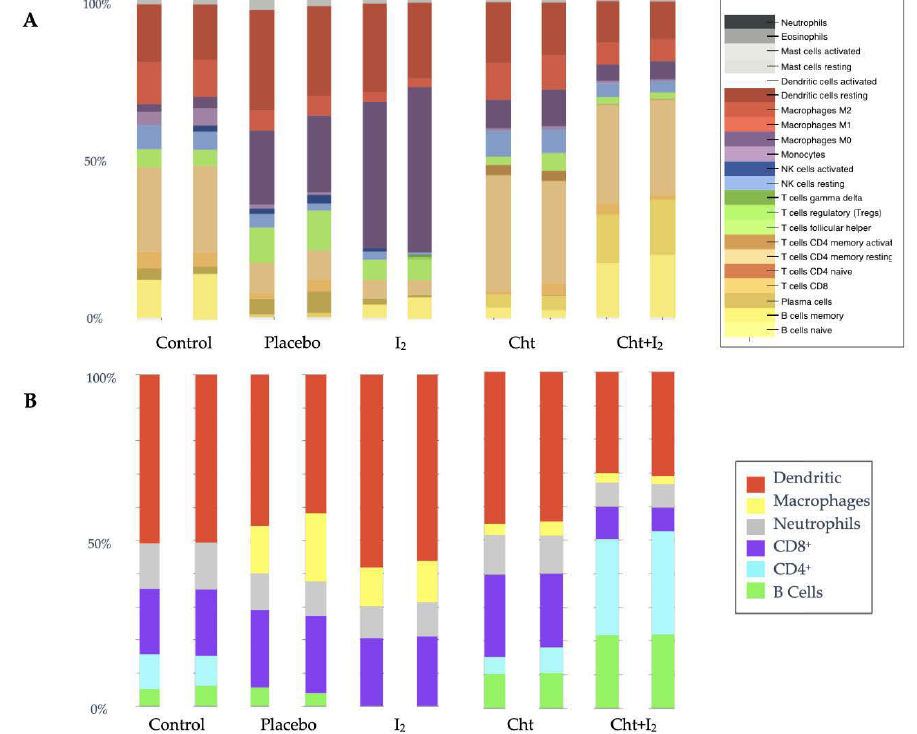
Figure 2. Deconvolution analysis of the relative composition of immune cells from two different pools of samples of each group. ( A ) Deconvolution performed with CIBERSORT. ( B ) Deconvolution obtained with ICTD. In both panels, Control bar corresponds to the non-cancer tissue (normal breast sample pool), placebo and I 2 correspond to early-stage tumors and Cht and Cht+I 2 to those in advanced stages. The composition of the immune infiltrate is color-coded and presented on the right side of each